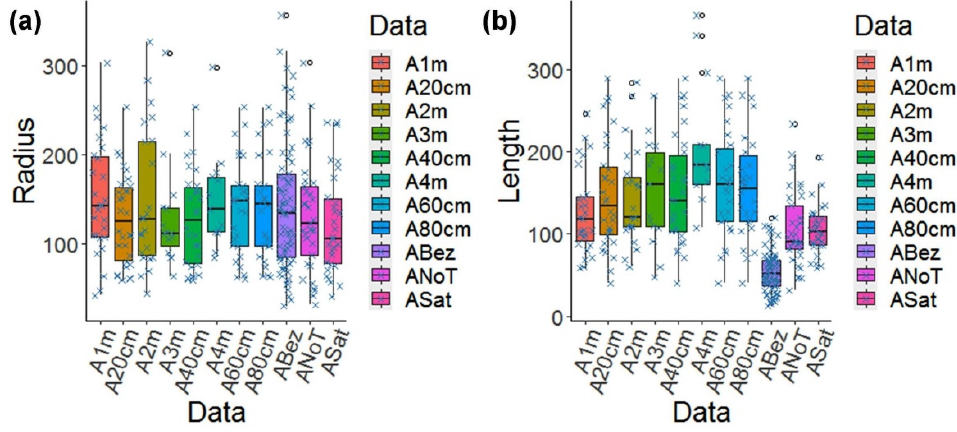
Figure 7. The mean curve radius ( a ) and length ( b ) values for the rural road and a box plot view of